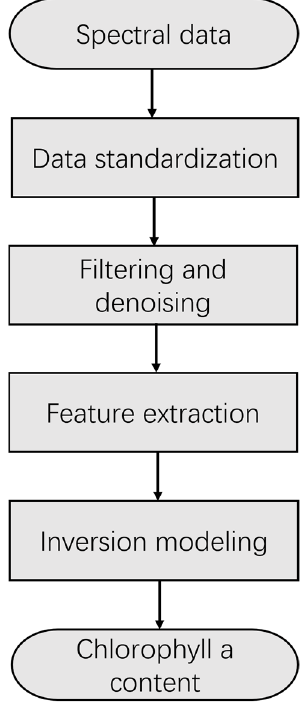
Figure 6. Data processing flow.